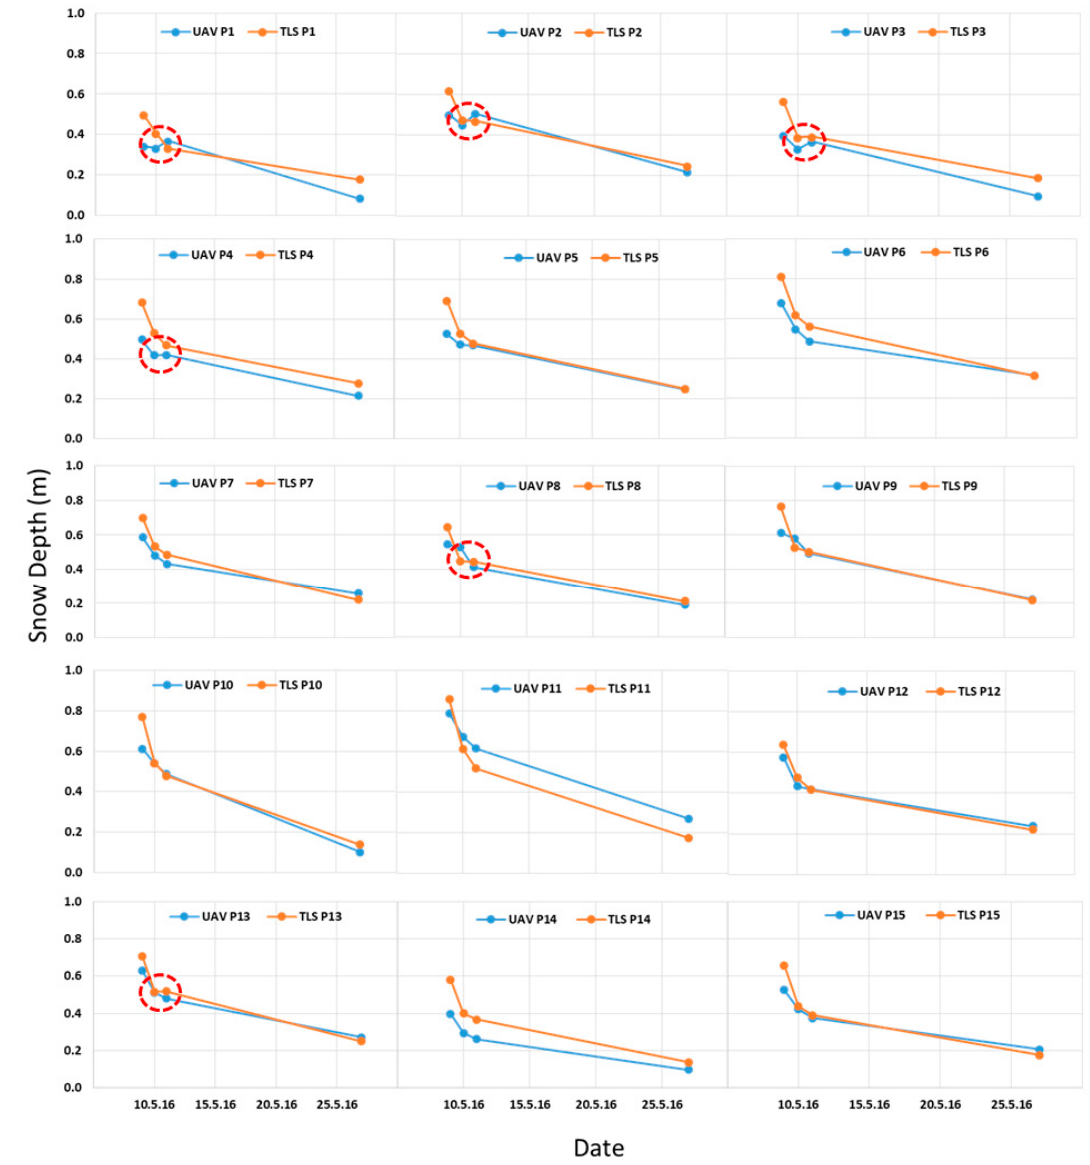
Figure 11. Change in HS observed from 15 points (P1, P2, . . . , P15) randomly distributed over snow-covered areas (See Figure 1) during four time series of both the UAS and TLS (i.e., 9, 10, 11, and 27 May 2016). Red circle shows an increase in HS in both UAS-DSM and TLS-DSM of 11 May 2016.